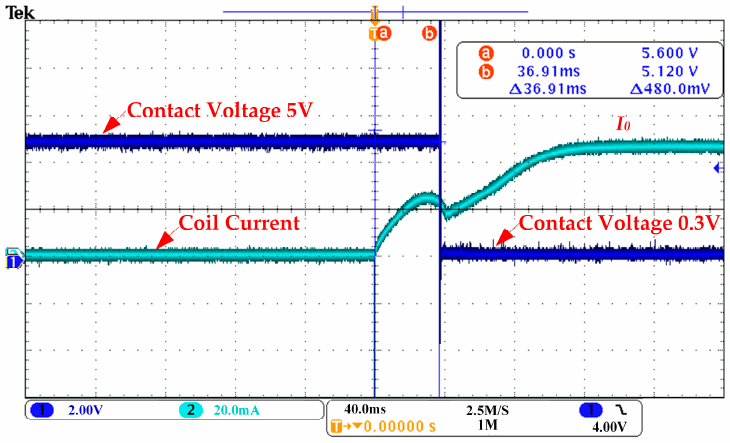
Figure 7. The waveforms of coil current and contact voltage measured using the oscilloscope.